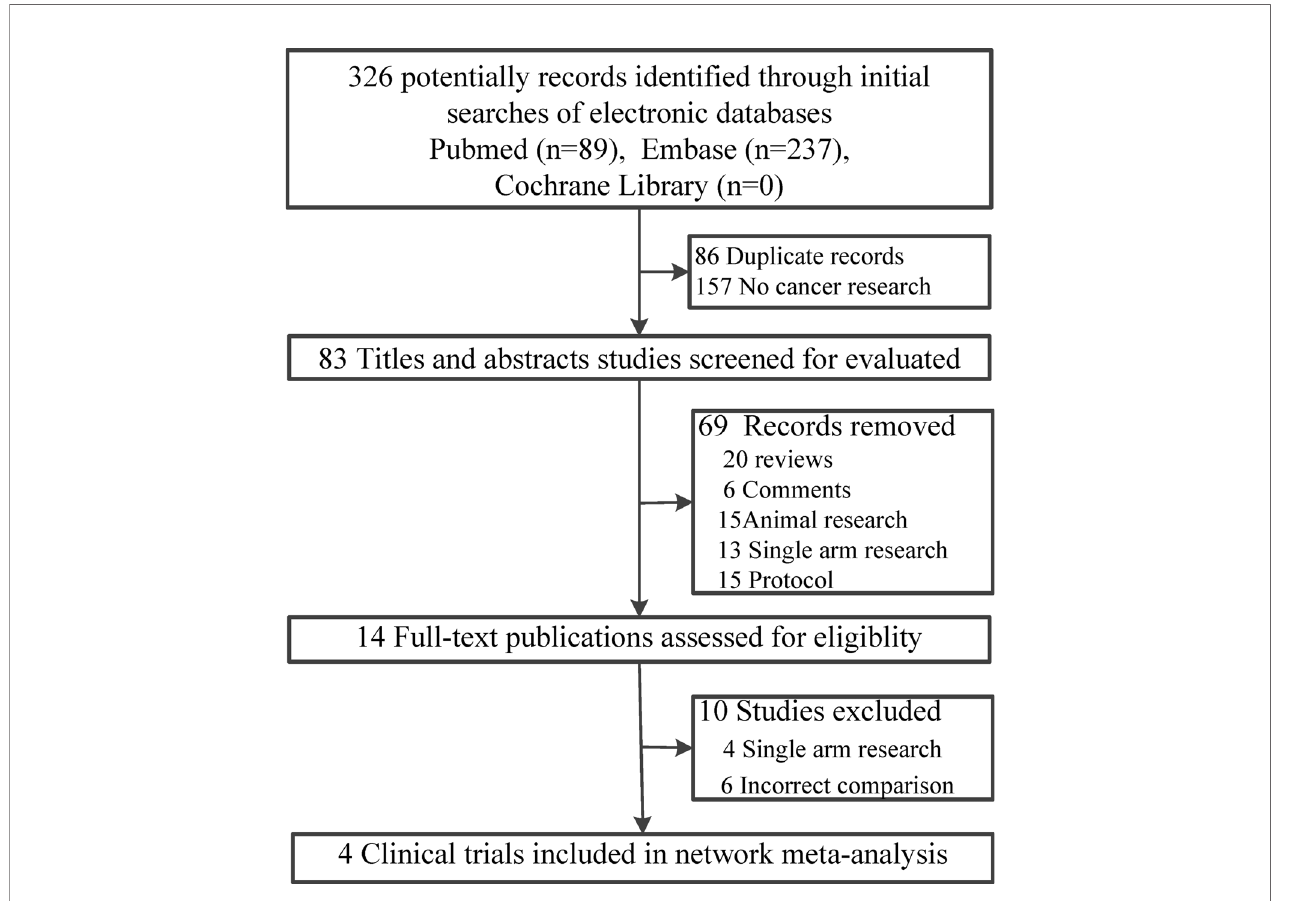
FIGURE 1 | Flow diagram of including clinical